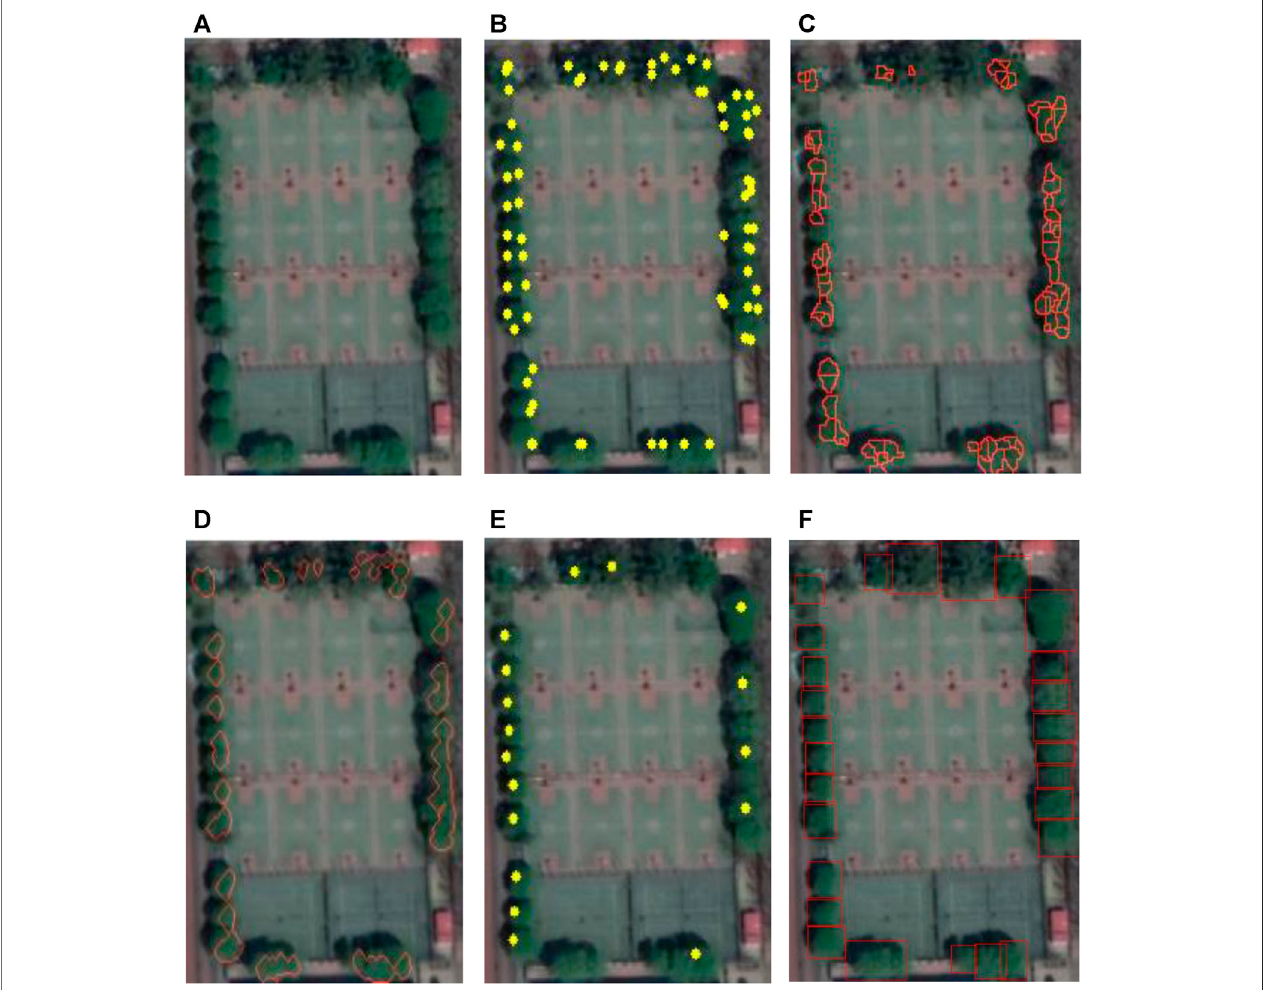
FIGURE5| Resultsofdifferentmethods incampus: (A) originalimage, (B) localmaximum, (C) watershed, (D) CVmodel, (E) template matching, and (F) YOLOv4- Lite.